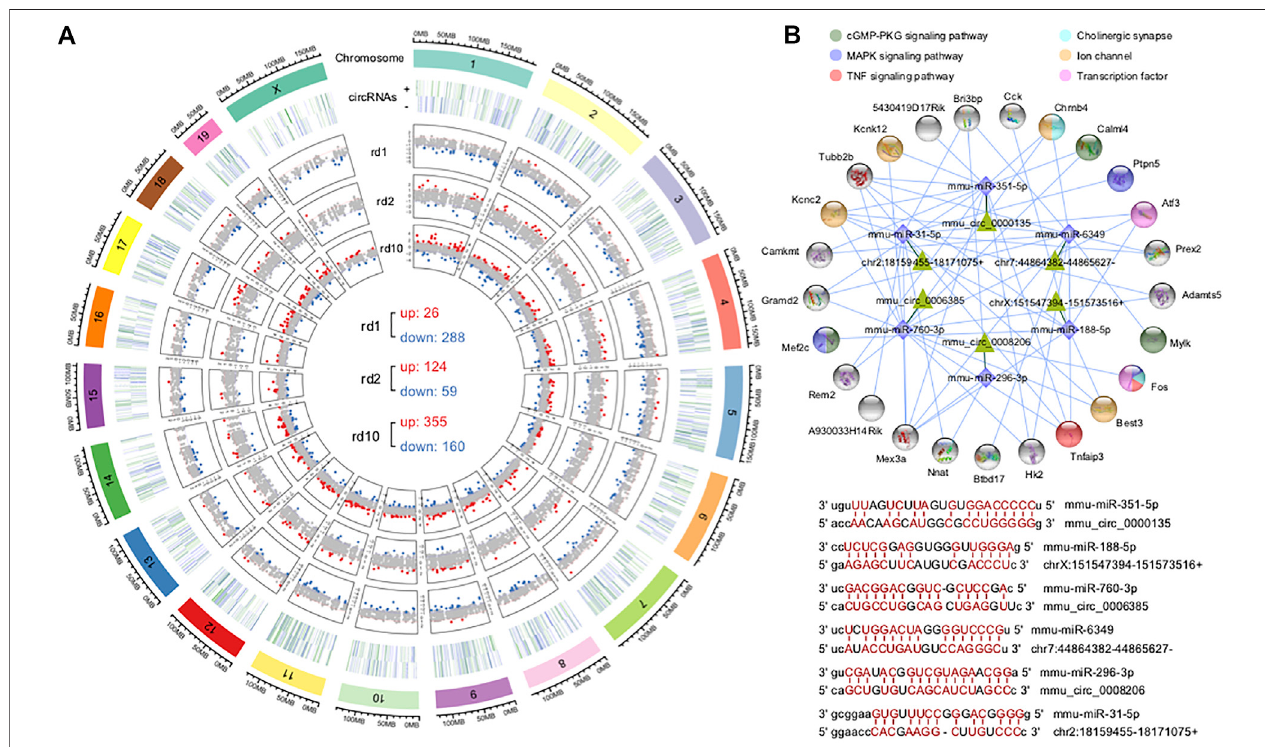
FIGURE6 | Identi fi cation ofdifferentially expressed circRNAs and construction ofceRNA networks. (A) Chromosomedistribution ofcircRNAs inmouse retina and theirfoldchangesinthethreeRDmodels; Therewere314DEcircRNAs (26up-regulatedand 288down-regulated),183DE-circRNAs (124up-regulatedand59down- regulated) and 515DE-cicrRNAs (355 up-regulated and160down-regulated)in Pde6b rd1 , Prph rd2 ,and Pde6b rd10 . (B) ThecircRNA-miRNA-mRNA interaction network constructed using the common DE circRNAs and DEGs of the three RD mouse models; representative circRNA-miRNA interaction sites predicted by miRanda. These DE circRNAs were enriched in cGMP-PKG signaling pathway, MAPK signaling pathway, TNF signaling pathway, ion channel, transcription factor and cholinergic